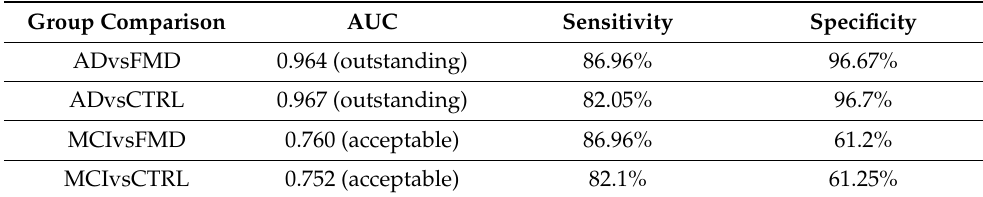
Table 5. ROC Curve—T5P total score ≤